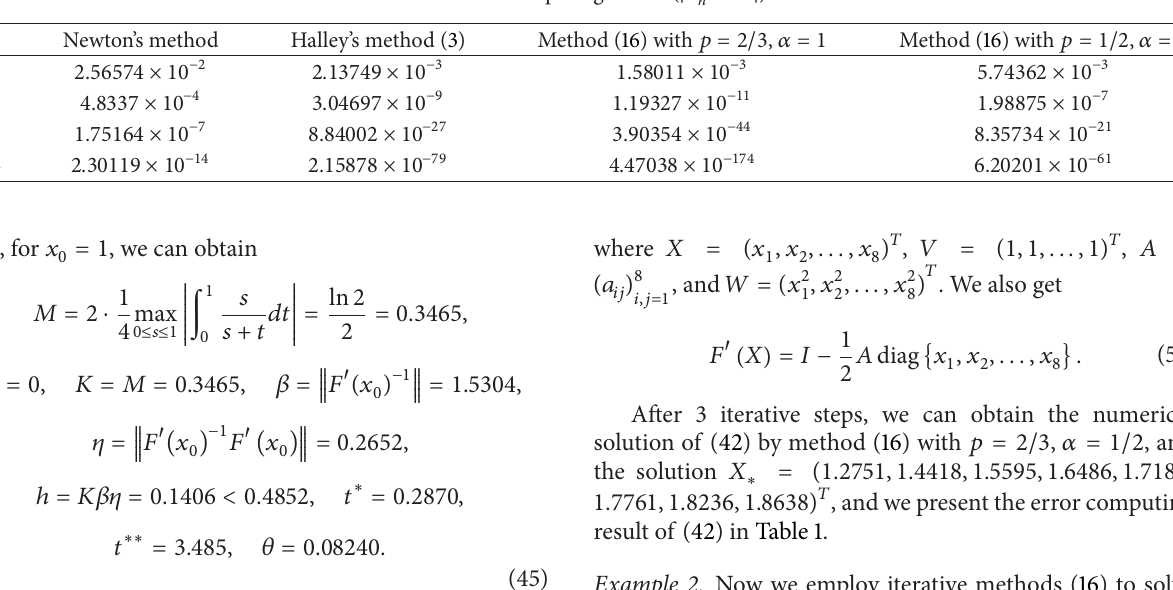
Table 2: Error computing results ( |𝑥 𝑛 − 𝑥 ∗ |